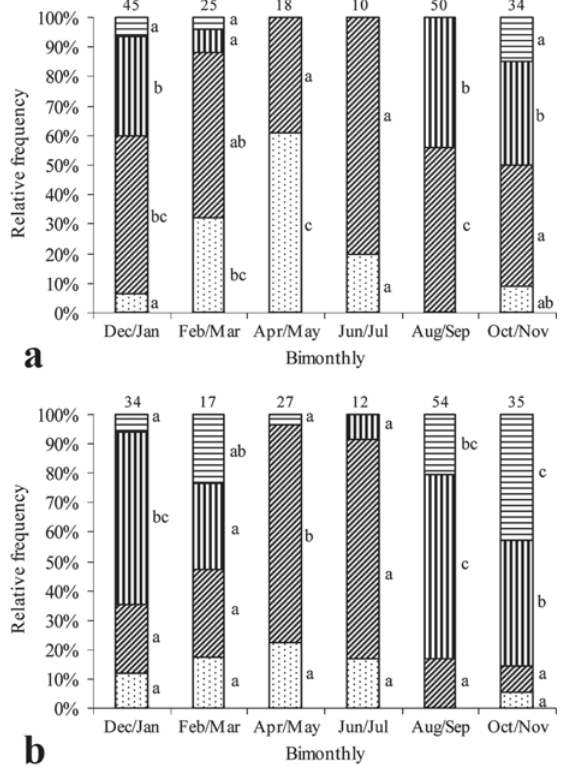
Fig. 1. Relative bimonthly frequency (%) of gonadal maturation stages for males (a) and females (b) of Cichla piquiti sampled between December 2004 and November 2005 [resting (dotted), initial maturation (oblique lines), advanced maturation (vertical lines), partially spent (horizontal lines)]. Absolute frequencies of each gonadal maturation stage along the bimesters followed by different letters are significantly different (G-test of independence, p < 0.05). Sample size is given above